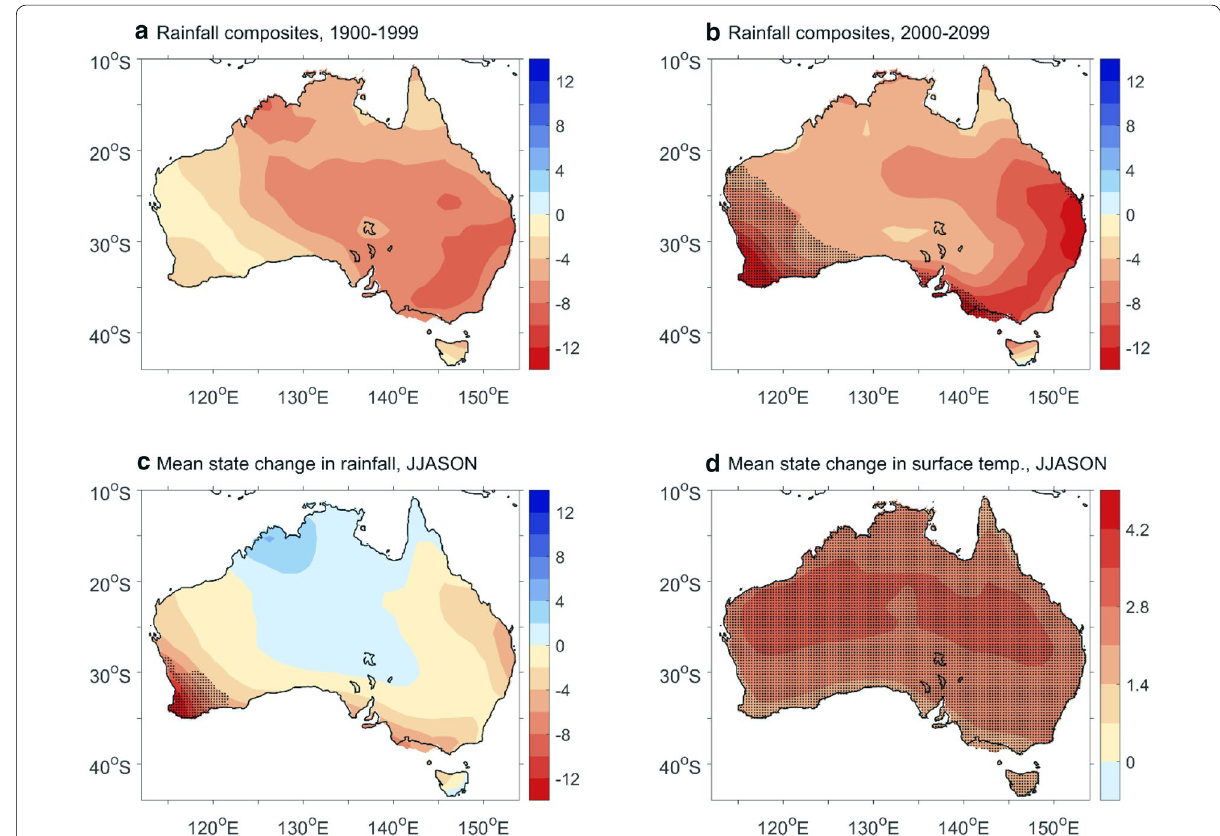
Fig. 4 Possible influences from mean state change under greenhouse warming based on CMIP5. a Composites of JJASON mean rainfall anomalies (mm per month) for events that are similar to 2018–2019 sequences in the Control climate, i.e., 1900–1999. b The same as a , but for the Future climate, i.e., 2000–2099. Dotted areas indicate where the difference between a and b is significant at the 95% confidence level based on a Student t -test. c Projected changes in Australia JJASON rainfall between 2000–2099 and 1900–1999. d The same as c , but in surface temperature (°C). Results are based on 17 CMIP5 models that produce reasonable ENSO diversity (Cai et al. 2018). Dotted area in c and d indicate where the difference between two period is significant above the 95% confidence level based on a Student